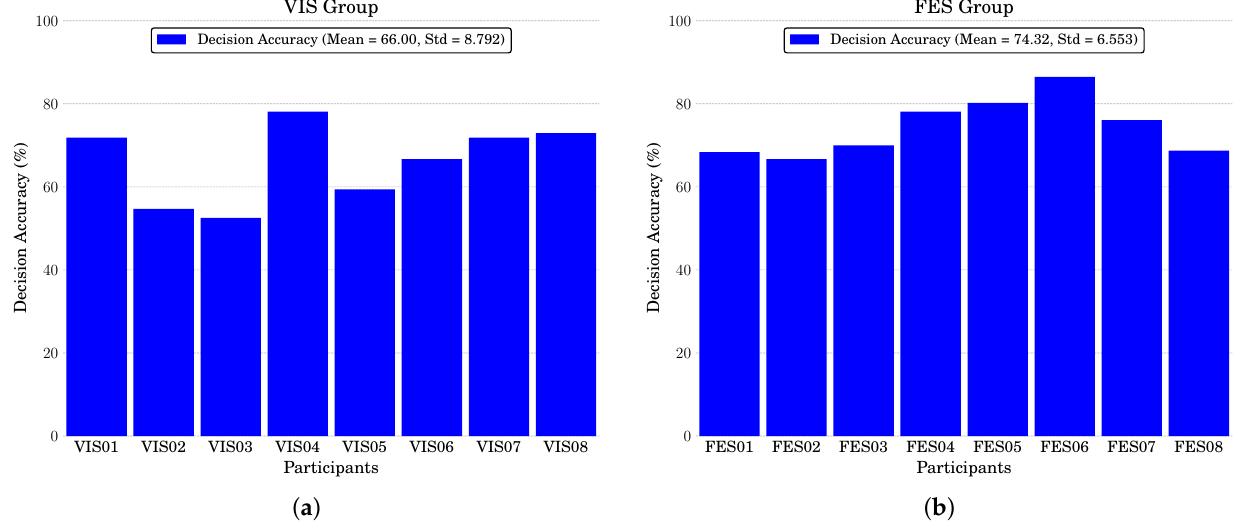
Figure 4. Accuracies of the online feedback of eight participants from the ( a ) VIS and ( b ) FES groups while conducting an online motor imagery feedback